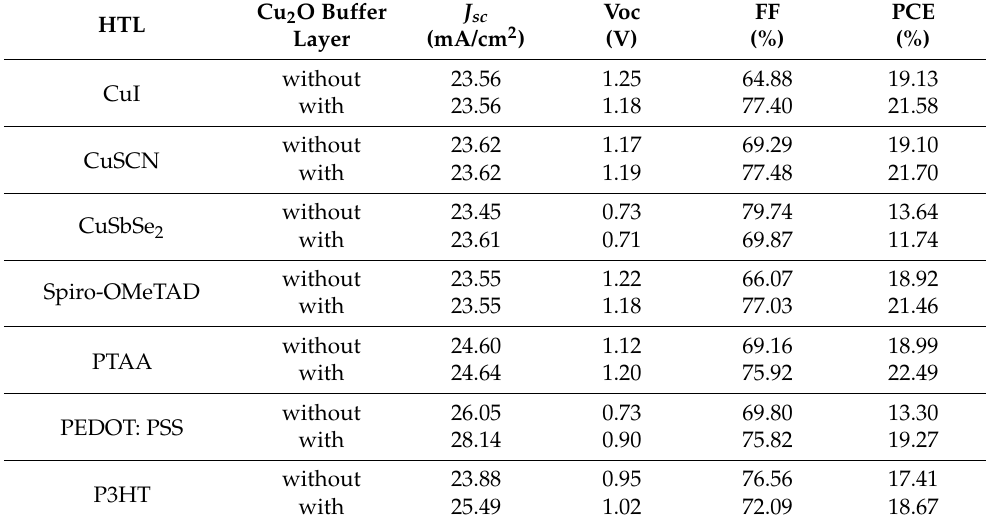
Table 4. Photovoltaic parameters obtained using different HTLs.